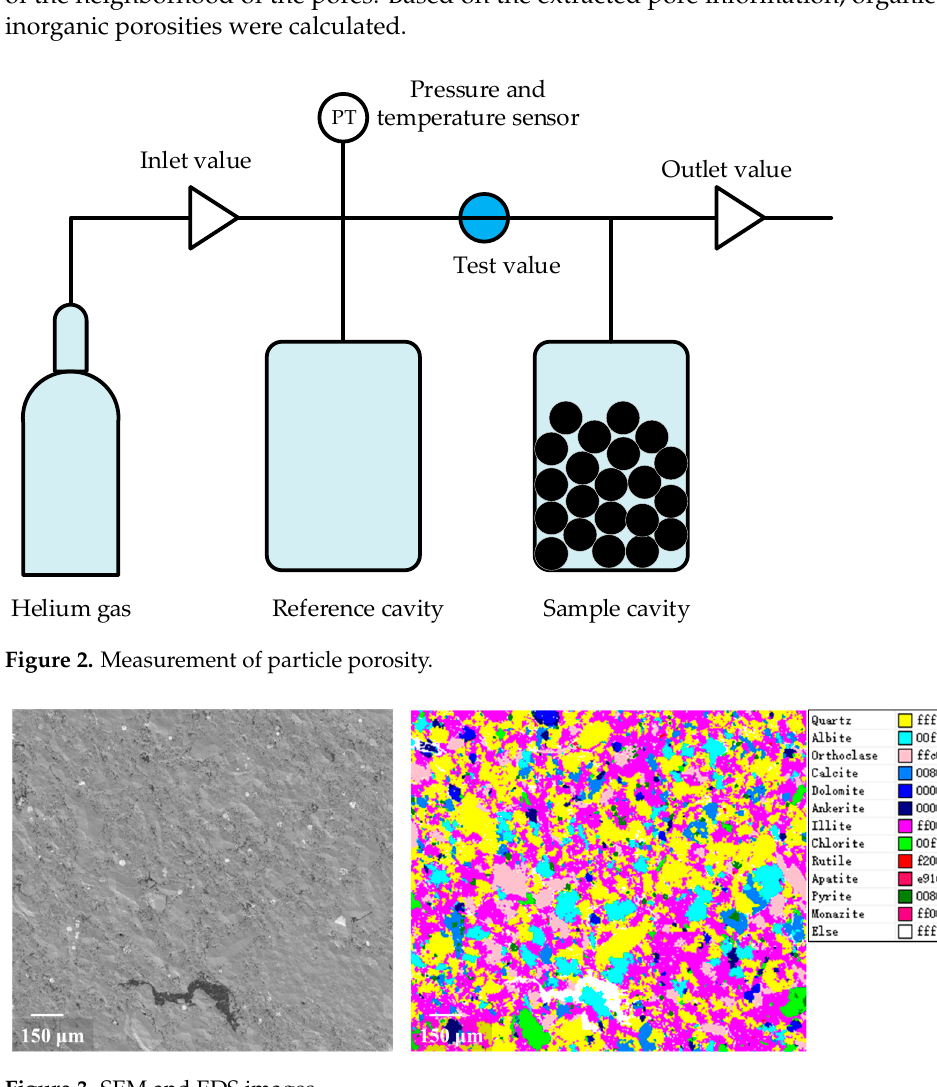
Figure 3. SEM and EDS